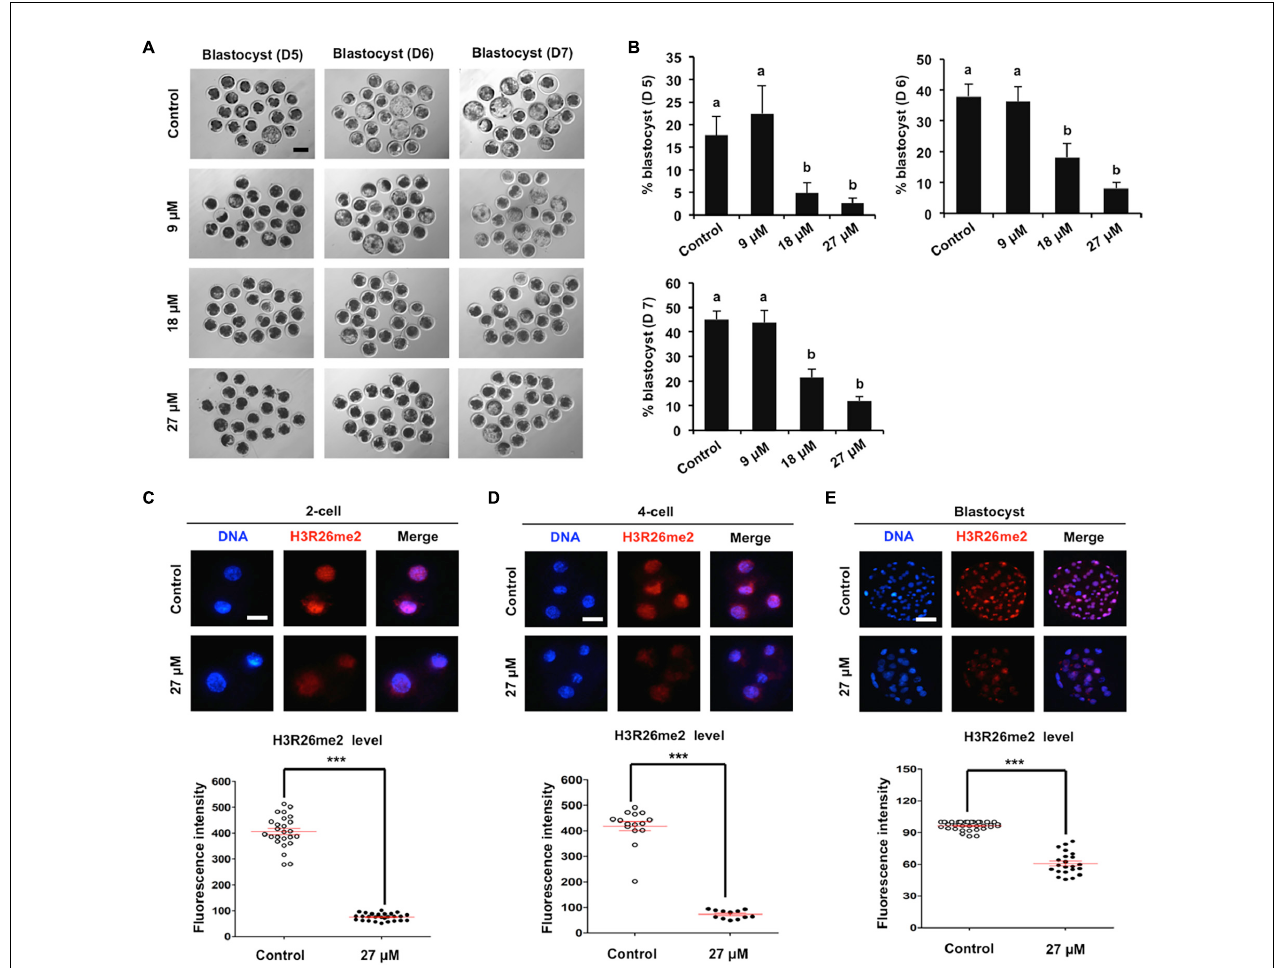
FIGURE 2 | Effect of CARM1 inhibition on blastocyst development and H3R26me2 levels in embryos. (A) Representative images of blastocysts at days 5, 6, and 7 from control and treatment groups. Scale bar: 100 µ m. (B) Effect of treatment of CARM1 inhibitor with different concentrations on blastocyst rates. Effect of CARM1 inhibition on H3R26me2 levels in 2-cell (C) , 4-cell (D) , and blastocysts (E) . Embryos at different stages were stained for H3R26me2 (red) and DNA (blue). The experiment was independently repeated three times with at least 12 embryos per group. Scale bar: 50 µ m. All data are shown as mean ± S.E.M and different letters on the bars or asterisks indicate significant differences ( P <